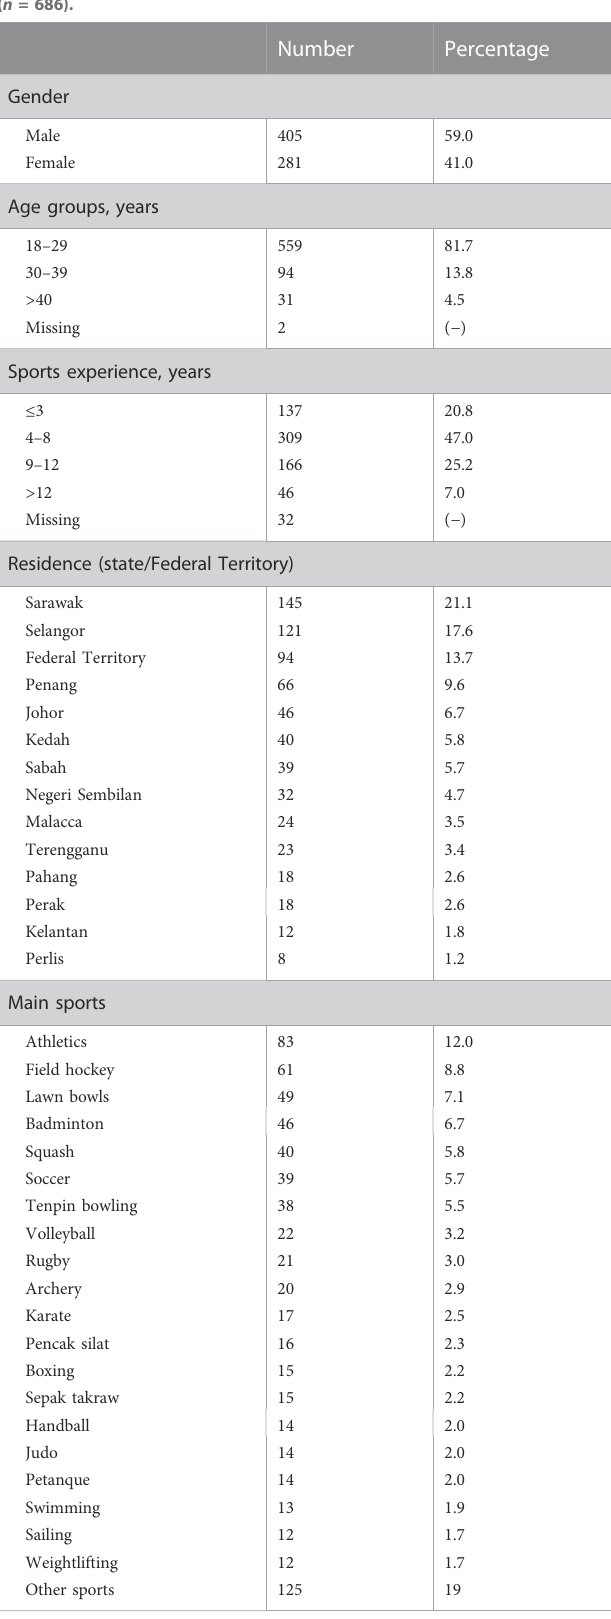
TABLE 1 Socio-demographic characteristics of the respondents in Malaysia during the 2020 COVID-19 lockdown under a national Movement Control Order ( n =